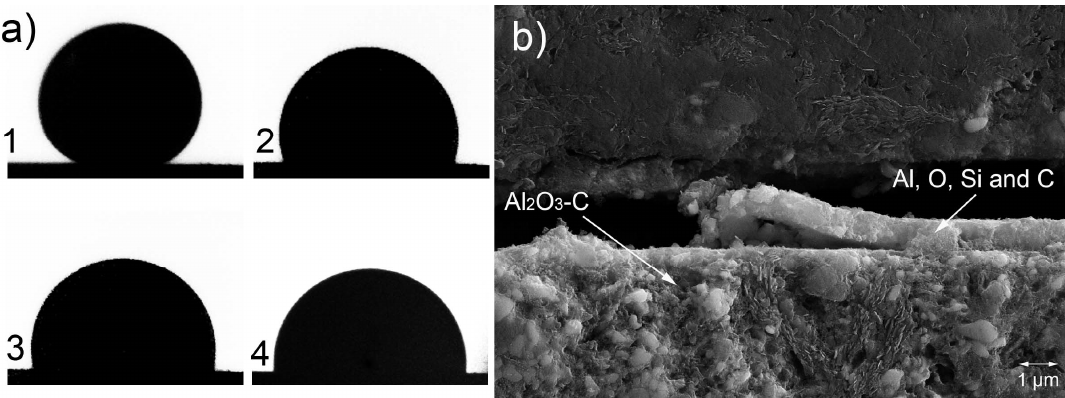
Figure 3. Conventional sessile drop experiment at 950 °C. ( a ) Photo sequence of the sessile drop experiment, ( b ) SEM micrograph of the Al 2 O 3 -C sample after conventional sessile drop test with AlSi7Mg with interfacial layer without AlSi7Mg drop due missing attachment between drop and substrate.